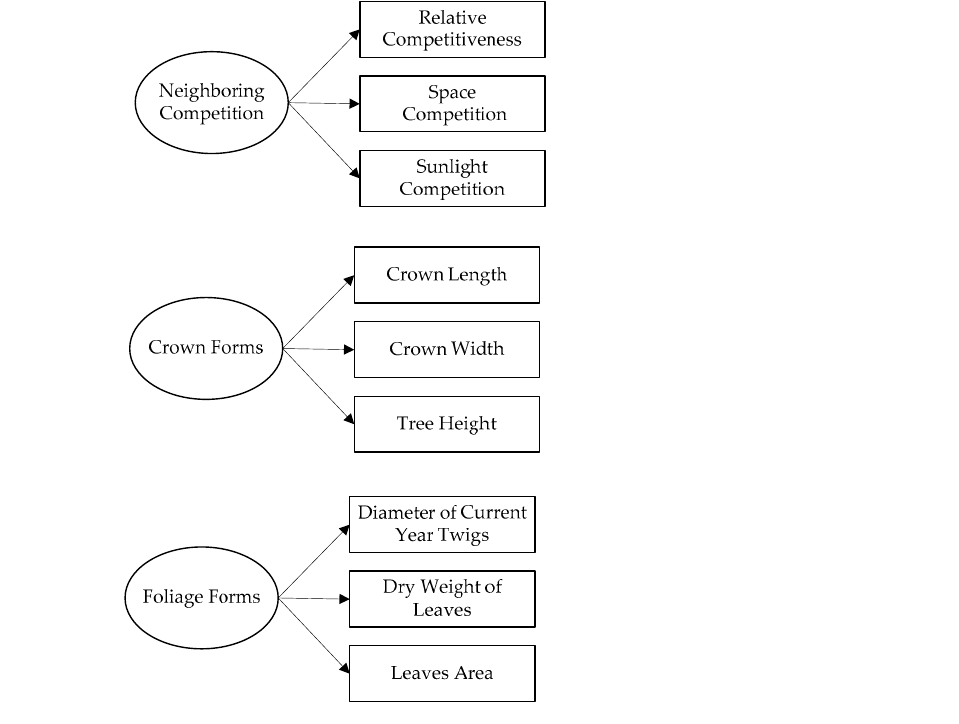
Figure 3. The measurement model used in this study with the ovals depicting a latent variable and the rectangles depict observed variables. Single arrowheads from the latent variable to the observed variables represent direct effects.